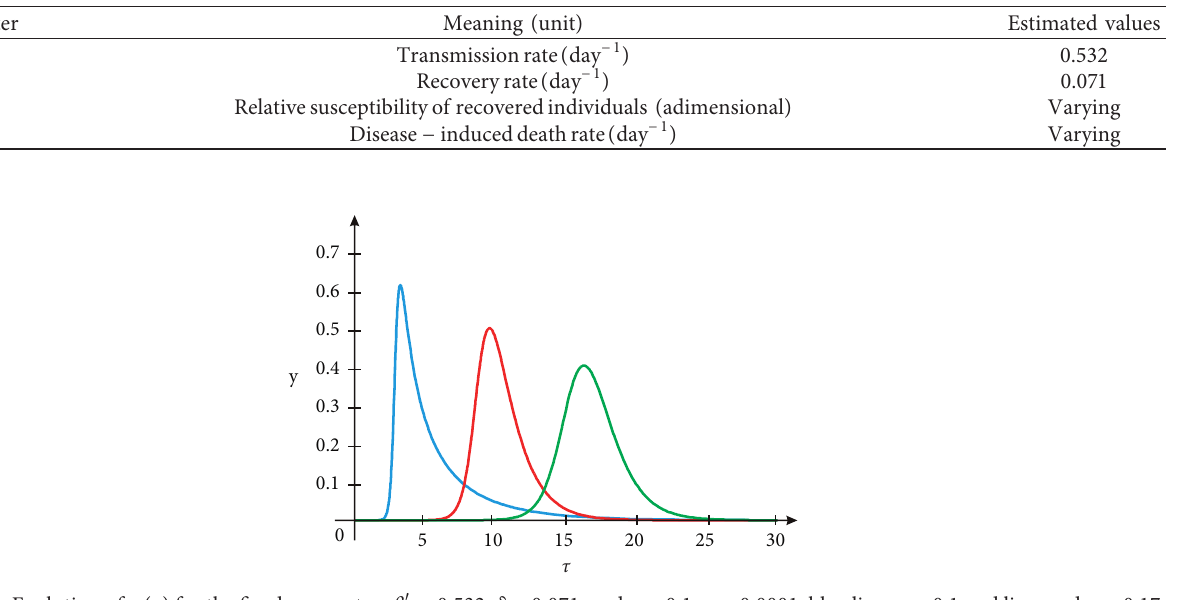
Figure 4: Evolution of y ( τ ) for the fixed parameters β ′ � 0 . 532, δ � 0 . 071, and σ � 0 . 1. α � 0 . 0001, blue line; α � 0 . 1, red line; and α � 0 . 17, green line.